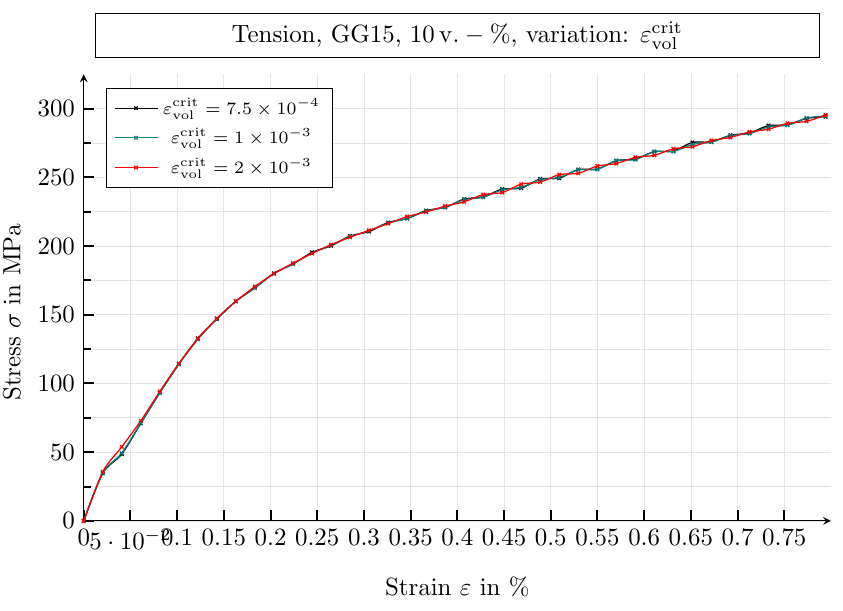
Figure 11. Influence of the threshold value of the volume change on the macroscopic stress–strain behaviour. Simulations at room temperature, using GJL-150 SVEs with a graphite flake fraction of 10v. %. For a constant minimum value of the degradation function of d min = 0.05, the threshold of − the volume change is varied for the values ε crit